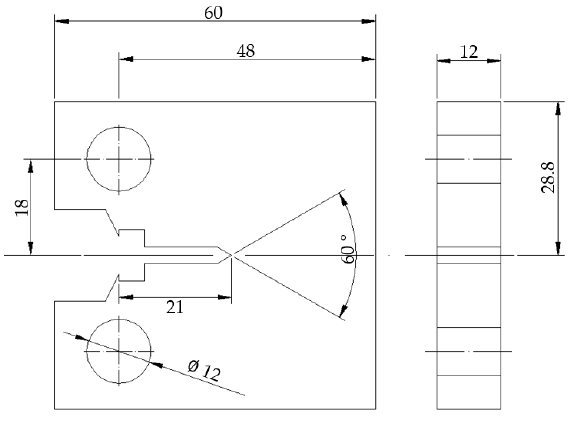
Figure 4. Compact tension specimen of crack tip opening displacement (CTOD) test.